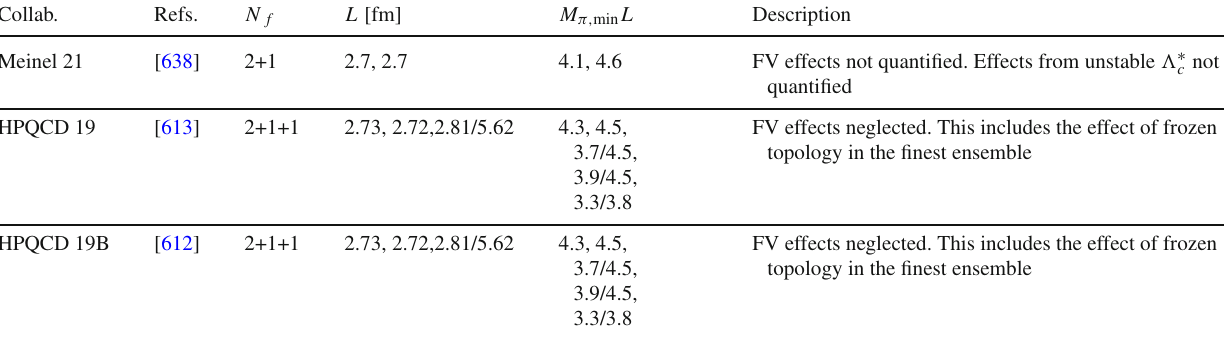
Table 167 Finite-volume effects in determinations of B ( s ) → D ( ∗ ) ( to a differentlattice spacing, with multiple spatial volumes at some lattice spacings. For actions with multiple species of pions, the lightest pion masses are quoted